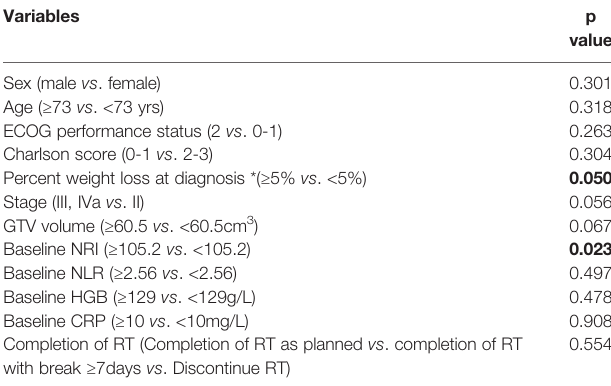
TABLE 3 | Correlation between tumor response and clinical variables (n =